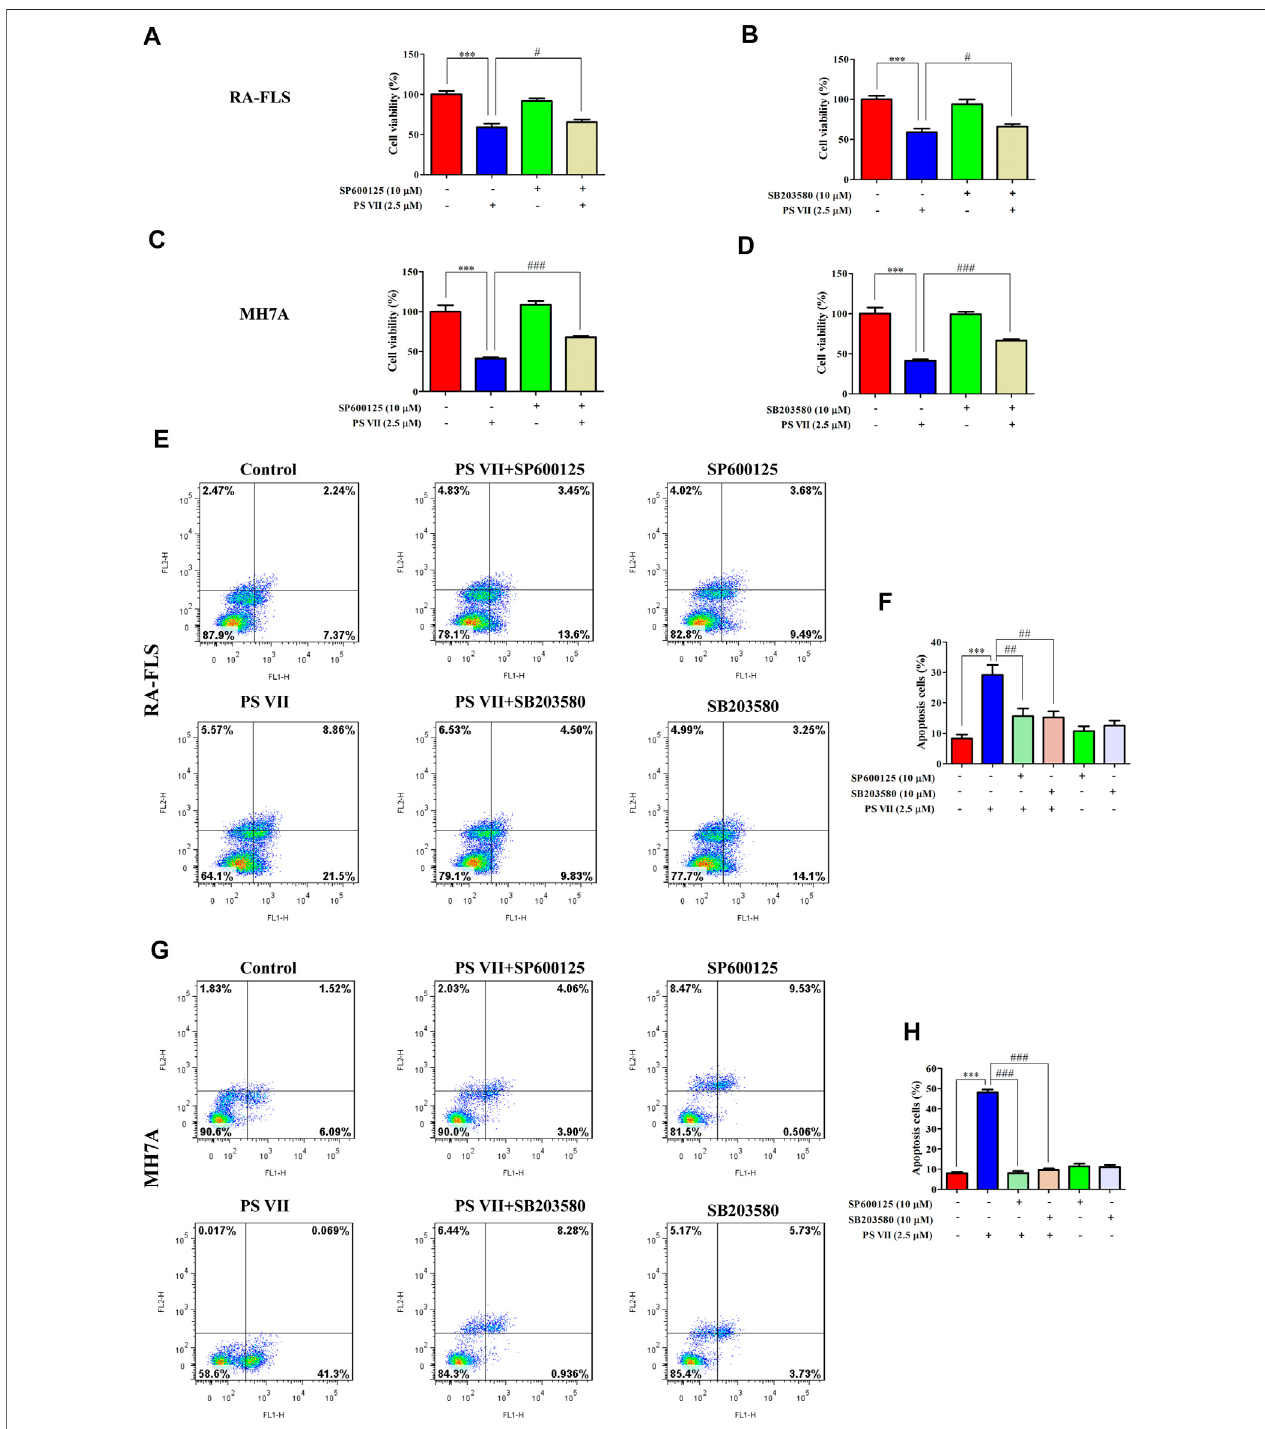
FIGURE 7 | Effects of PS VII and inhibitors of JNK (SP6001256), p38 (SB203580) on the cell proliferation and apoptosis of RA-FLS and MH7A cells. Cells were treatedwithPSVII(2.5 μ M),SP600125(10 μ M),SB203580(10 μ M)orSP600125,andPSVII,SB203580andPSVIIwereco-culturedfor48 h. (A,B) CellviabilityofRA- FLScellswasdeterminedbyMTTassay. (C,D) CellviabilityofMH7AcellswasdeterminedbyMTTassay.Flowcytometrywasusedtodeterminetheextentofapoptosis in RA-FLS (E) and MH7A cells (G) . (F, H) The populations of apoptotic cells were evaluated as the percentage of total cells. Compared with the control group, *** p < 0.001. Compared with the PS VII group, # p < 0.05, ## p < 0.01, ### p < 0.001.